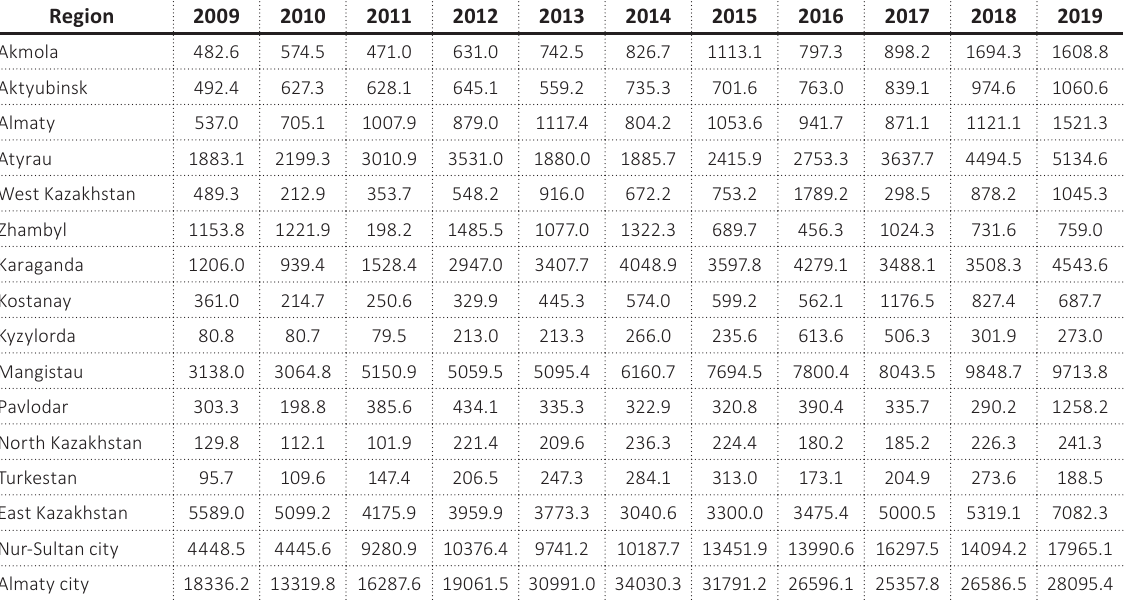
Table 4. Internal costs on R&D for 2009–2019, in million